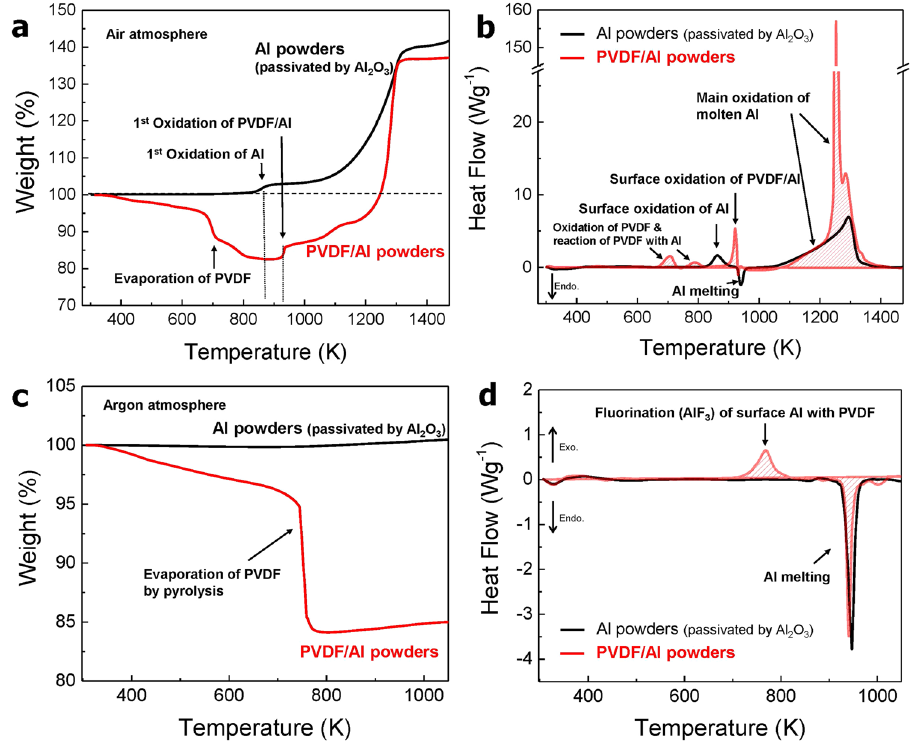
Figure 3. Comparison of the TGA/DSC curves between the PVDF/Al and the Al 2 O 3 passivated Al powders in ( a , b ) air and ( c , d ) an argon